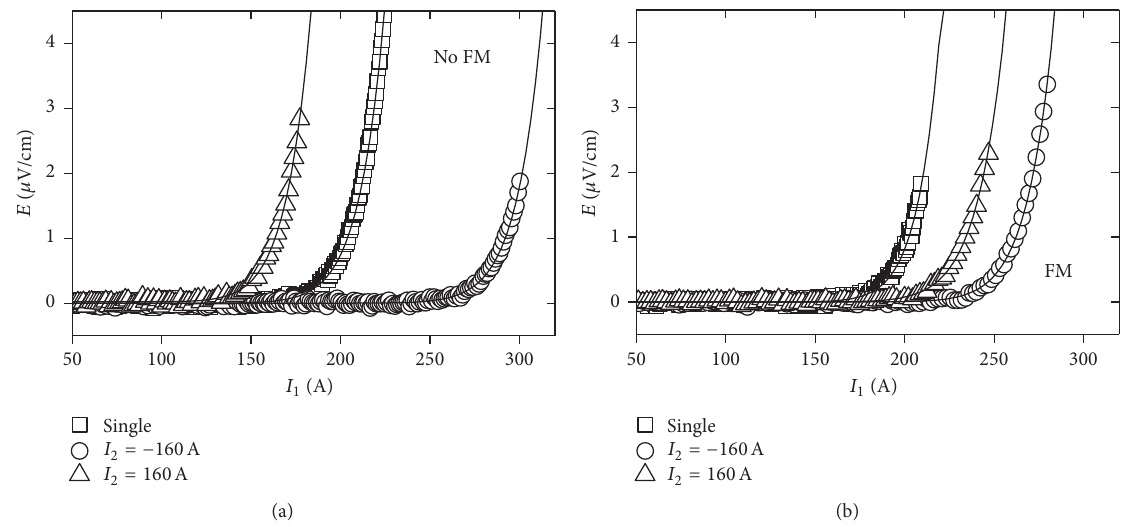
Figure 4: 𝐸 - 𝐼 curves of BSCCO tape for single ( ◻ ) and stacked conductors ( ⃝ and △ ) with different currents of ± 160A applied to the adjacent BSCCO tapes without (a) and with (b)